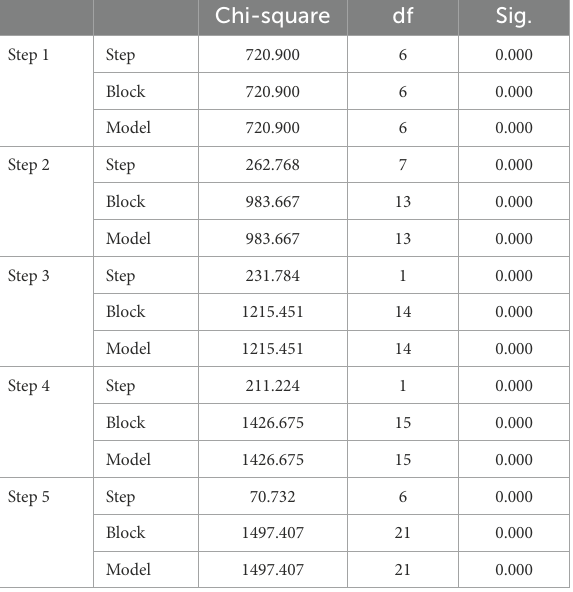
TABLE 5 Omnibus tests of model coefficients (Forward: